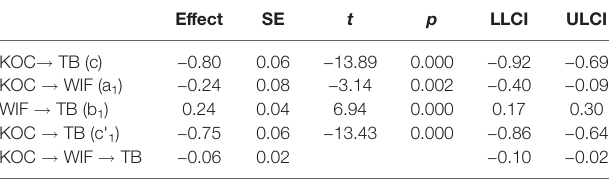
TABLE 4 | Mediating effect of